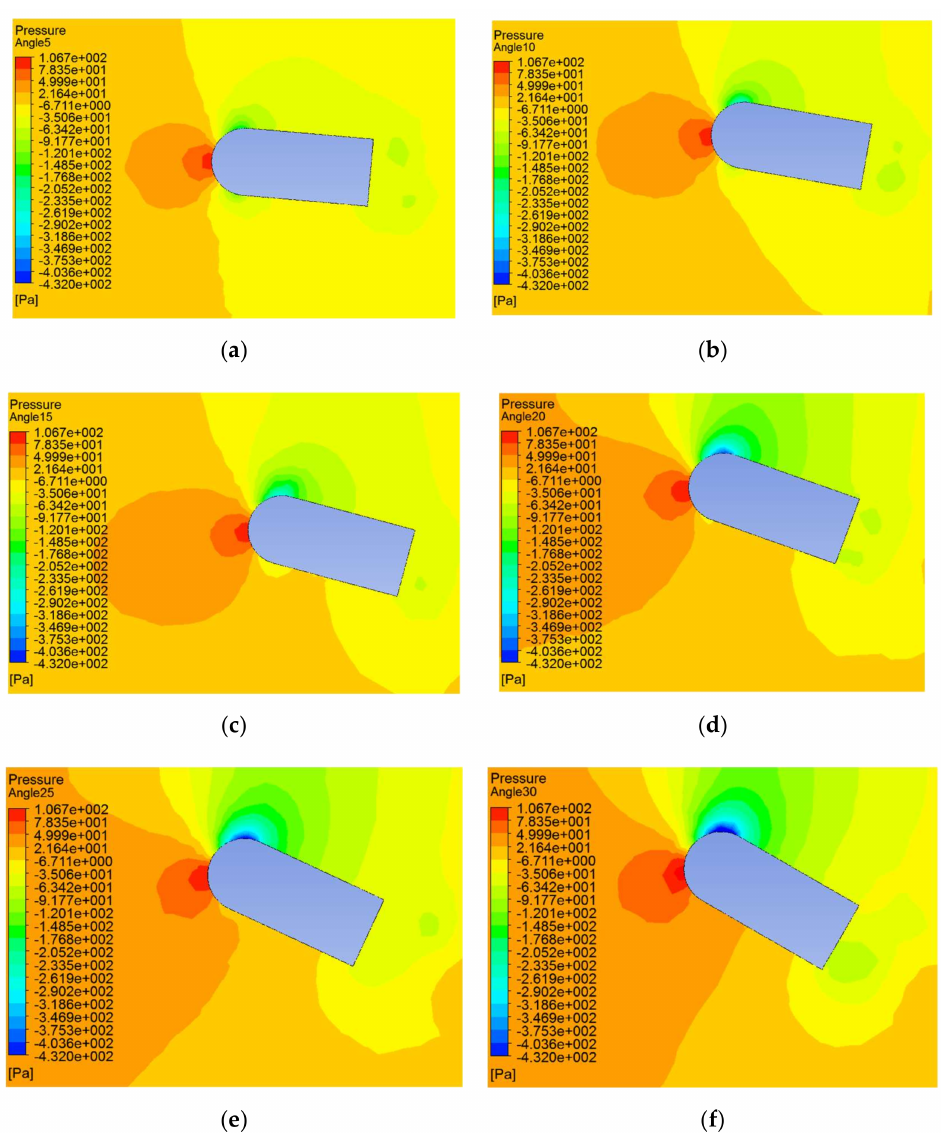
Figure 10. Static pressure distributions at di ff erent flow angles. ( a ) A flow angle of 5 ◦ ; ( b ) A flow angle of 10 ◦ ; ( c ) Flow angle is 15 ◦ ; ( d ) Flow angle is 20 ◦ ; ( e ) A flow angle of 25 ◦ ; ( f ) A flow angle of 30 ◦